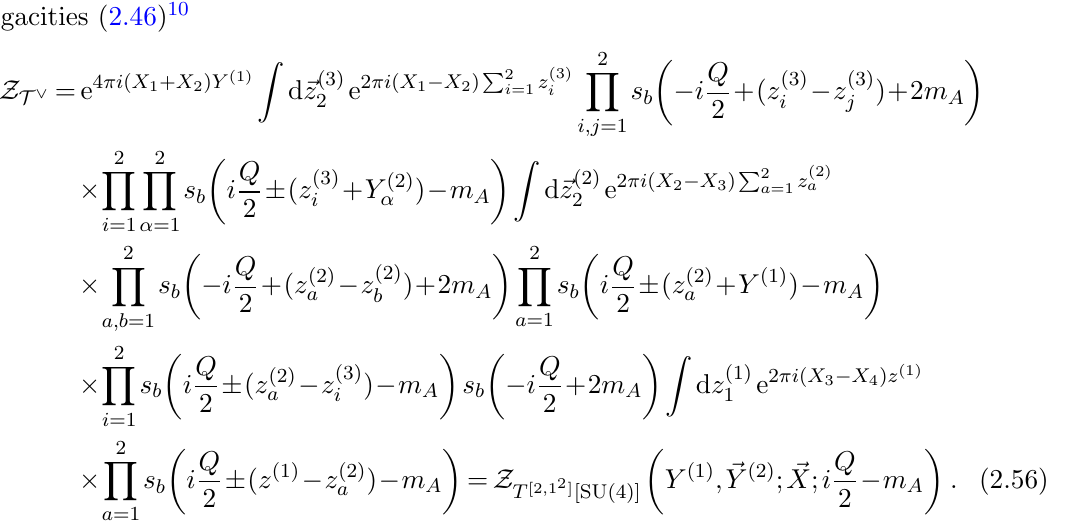
Figure 11 . Quiver representation of the sequential application of Aharony duality that leads to T [2 ; 1 2 ] [SU(4)] starting from its (cid:13)ip-(cid:13)ip dual T _ . fugacities (2.46)